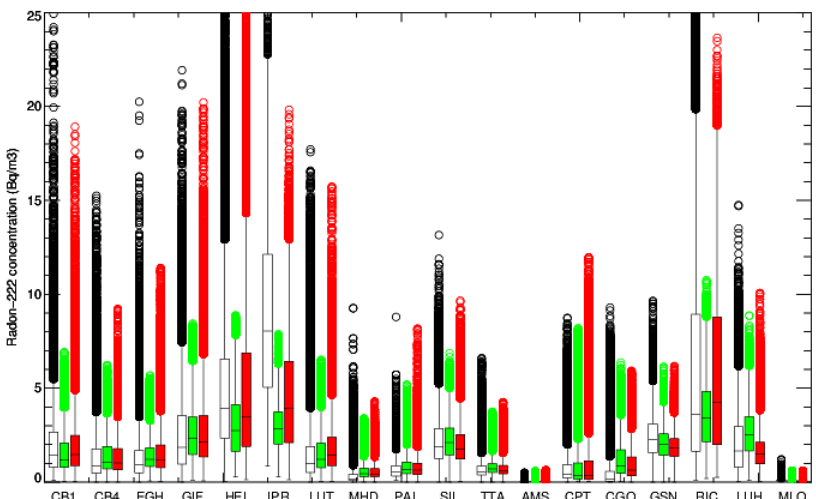
Figure 3. Comparisons of 222 Rn boxplot simulated by NP (red) and TD (green) versions of LMDz with boxplot based on measurements (black) sampled at 18 surface stations over a 6-year period (2006–2011). The bottom and the top of the box are the first and the third quartiles of the data distribution. The band inside the box is the median. The ends of the whiskers represent the lowest datum still within 1.5 · IQR (inter-quartile range) of the lower quartile and the highest datum still within 1.5 · IQR of the upper quartile. Stations are marked by three-letter abbreviations (see Table